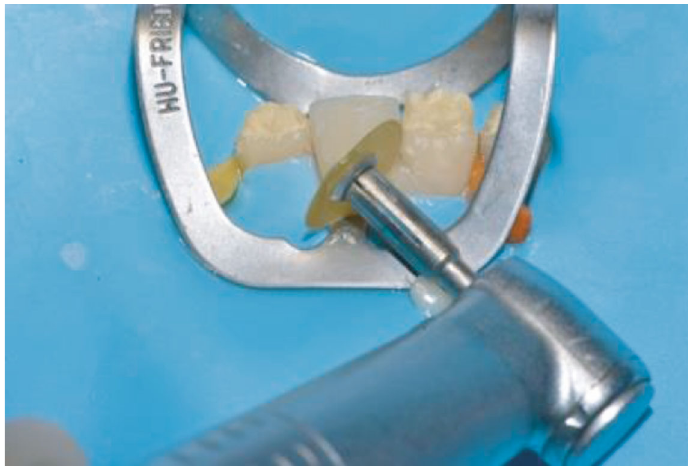
Figure 14: Finishing the margins with composite fi nishing discs.